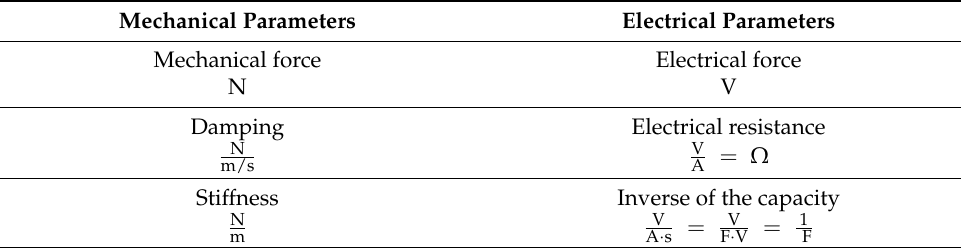
Table 2. Dimensional equivalences between the electrical and mechanical